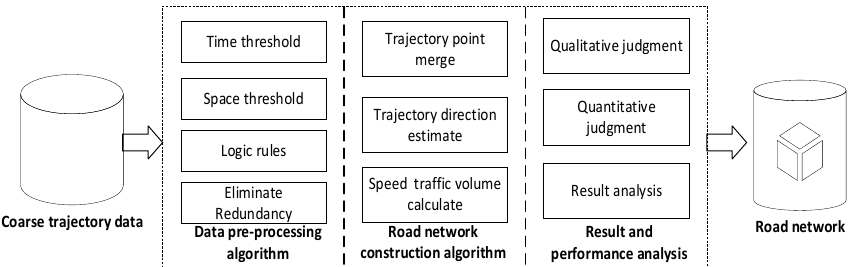
Figure 1. The framework of the map auto-construction method. First, a constraint rule-based trajectory data preprocessing algorithm is used to remove noise, which includes a time threshold, space threshold, logic threshold, and redundancy elimination. Second, a road network construction algorithm is used to generate a digital map using processes of trajectory point clustering, trajectory direction estimation, and average speed calculation. Third, the performance of the method is examined by comparing the constructed map with the OpenStreetMap and calculating the F-score for comparison with typical existing methods.